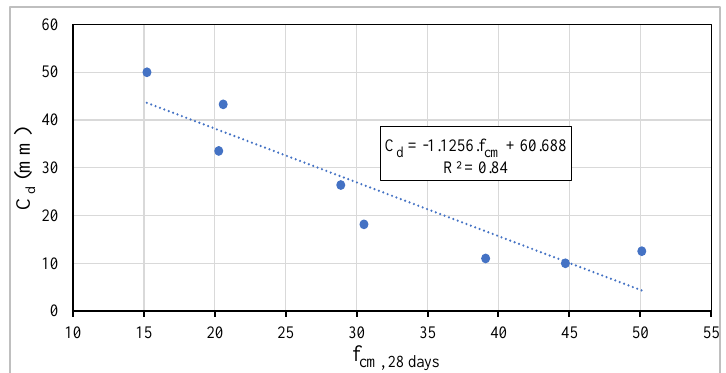
Figure 21. Relationship between carbonation depth after 42 days of exposure to CO 2 and mechanical strength at 28 days.